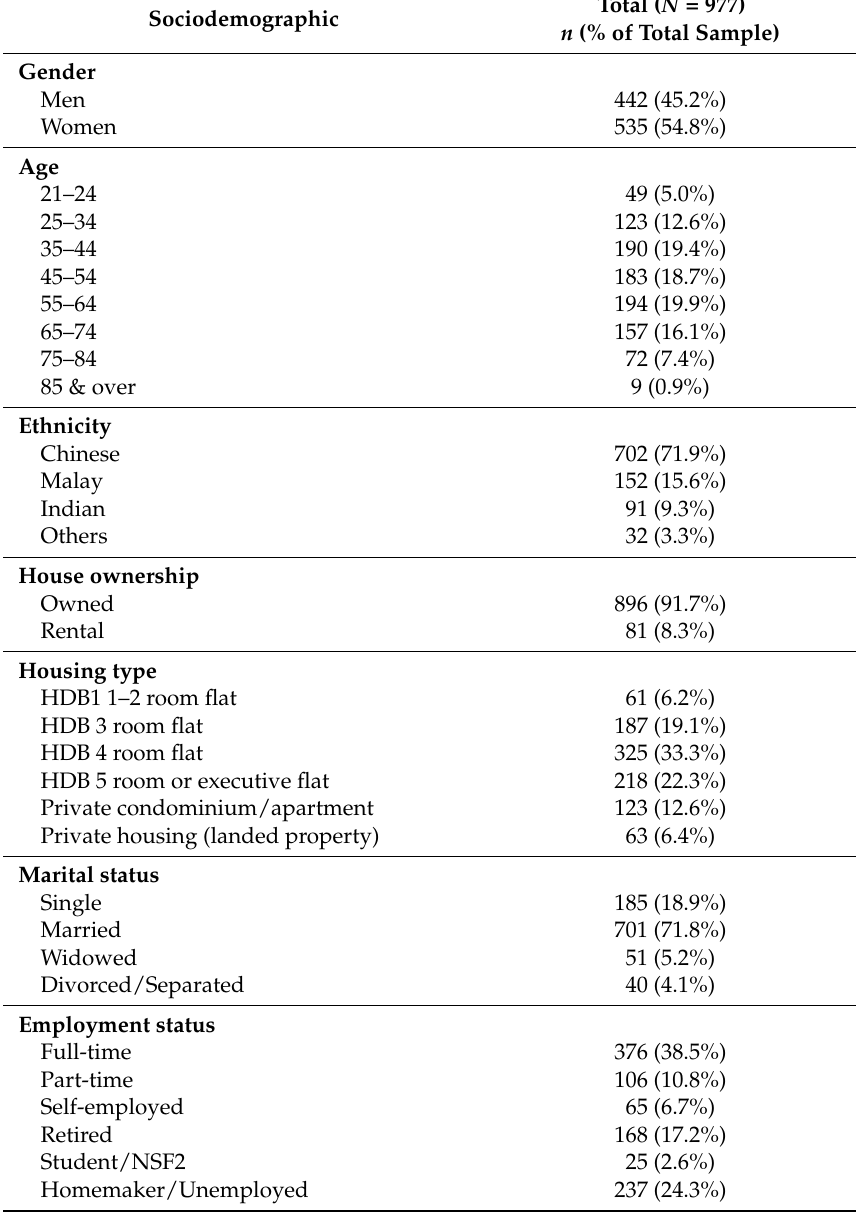
Table 2. Sampling stratification by demographic characteristics and housing